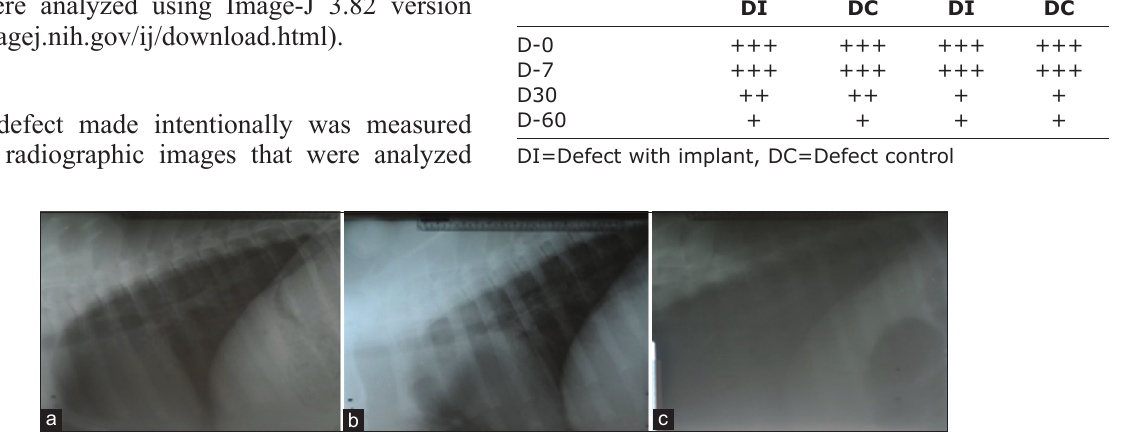
Figure-2: Laterolateral radiographic images (a) day 0, (b) day 30, (c) day 60.